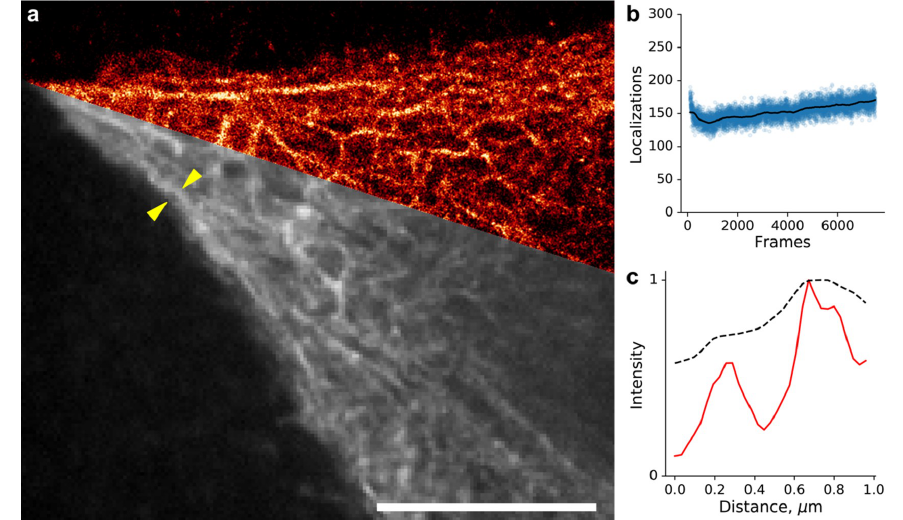
Figure 3. Super-resolution imaging with the DiB1 in the presence of compound 3 . ( a ) Live HeLa Kyoto cells were transiently transfected with cytokeratin-18-DiB1 and imaged in the presence of compound 3 (15 nM). Overlay of widefield (bottom) image and super-resolution reconstruction (top, from 3000 frames) are shown; scale bars are 10 μm. ( b ) The graph shows the number of localizations per frame. The laser illumination occurred without intermittence, and the frames were taken with 16 ms exposure. ( c ) Normalized intensity profiles between the arrowheads shown on the widefield image; black curve—widefield and red curve—super-resolution. The fluorescence was excited with 561 nm (60 W/cm 2 ) laser line.